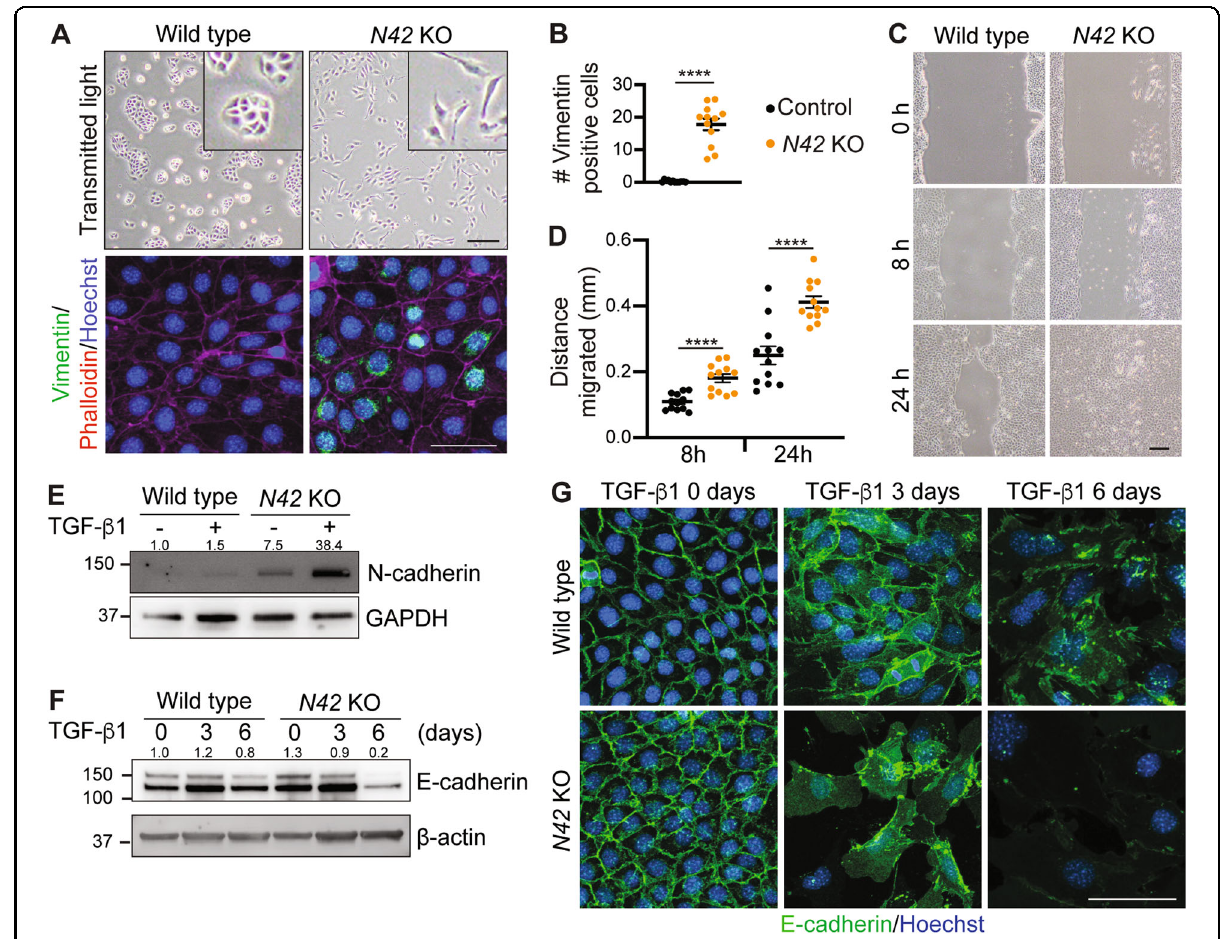
Fig. 6 Nedd4-2 KO CCD cells display EMT characteristics. A Light microscopy of wild type and Nedd4-2 KO cells, scale bar: 200 μ m (with higher magni fi cation inset) or immunostaining of vimentin (green) and Phalloidin (red) with Hoechst staining of DNA (blue). Scale bar: 50 μ m. B Number of vimentin-positive cells per fi eld of view, n = 4 clones, each with three fi elds of view. C Light microscopy of cells showing migration distance after scratch, scale bar: 200 μ m. D Migration distance quantitated in four clones, n = 3 replicates each. E Immunoblot analysis of N-cadherin with GAPDH as a loading control, untreated or after 72 h 2.5 ng/ml TGF- β 1 stimulation. Numbers indicate quantitation of N-cadherin bands relative to untreated wild-type lane, normalized to GAPDH. F Immunoblot analysis of E-cadherin with β -actin as a loading control, untreated or after 3 or 6 days of TGF- β 1 stimulation. Numbers indicate quantitation of E-cadherin bands relative to untreated wild type lane, normalized to β -actin. G Immunostaining of E-cadherin (green) after 0, 3, and 6 days of TGF- β 1 treatment. DNA is stained by Hoechst (blue). Scale bar: 50 μ m. Data presented as means ± SEM ( B , D ) and signi fi cance determined using unpaired two-tailed Student ’ s t test. **** P <